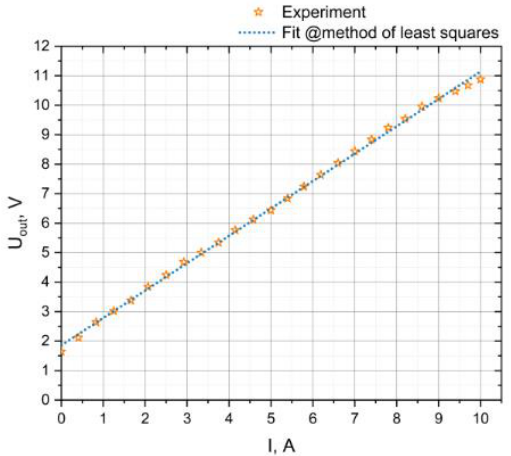
Figure 10. Output voltage versus measured current plot.